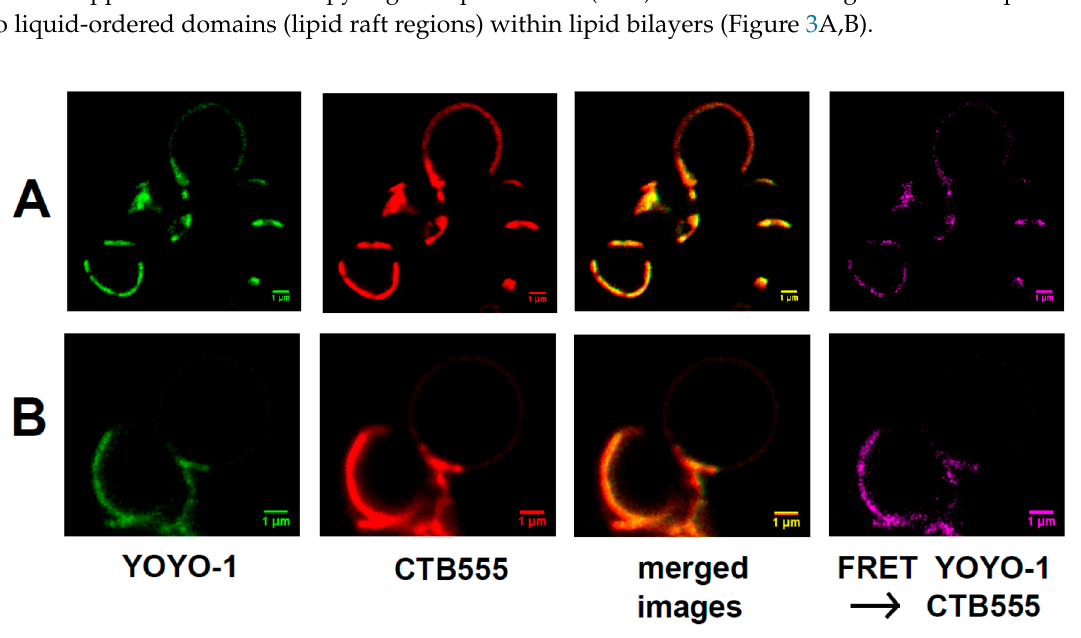
Figure 3. FRET microscopy for visualization of binding of raft RNA aptamers to giant lipid vesicles (GVs). Column I—YOYO-1 bound to raft RNA aptamers; column II—cholera toxin B conjugated to AlexaFluor-555 (CTB555) bound to GM1 within liquid ordered domains of giant lipid vesicle membrane (DOPC / SM / CH, 60:30:10 mole%, 0.1 mole% of ganglioside GM1); column III—merged images; column IV—FRET signal. The bars represent 1 µ m. ( A , B ) stand for two independent experiments.